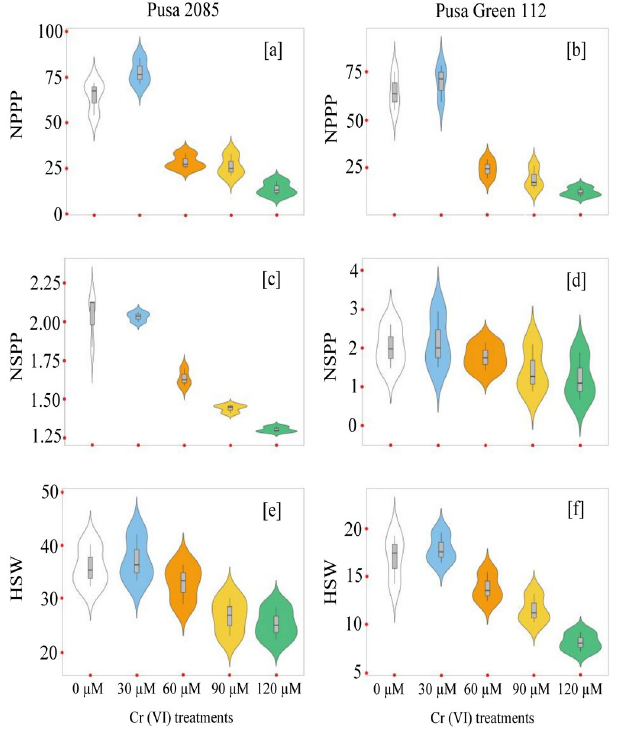
Fig 11. Violin plots showing the distributions of the number of pods per plant (NPPP) and the yield-related traits in two chickpea varieties, Pusa 2085 and Pusa Green 112, grown in pots under different chromium (Cr)